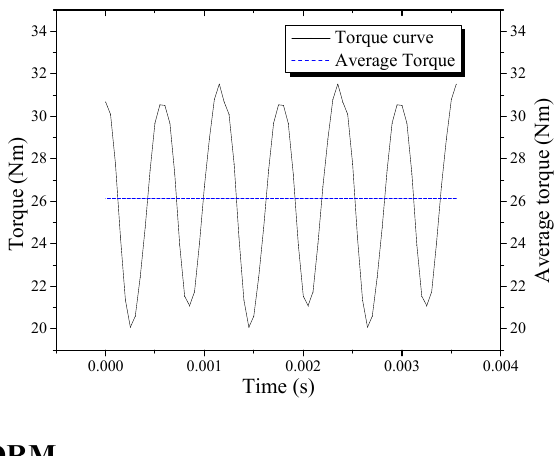
Figure 10. Torque curve from the 3D FEM